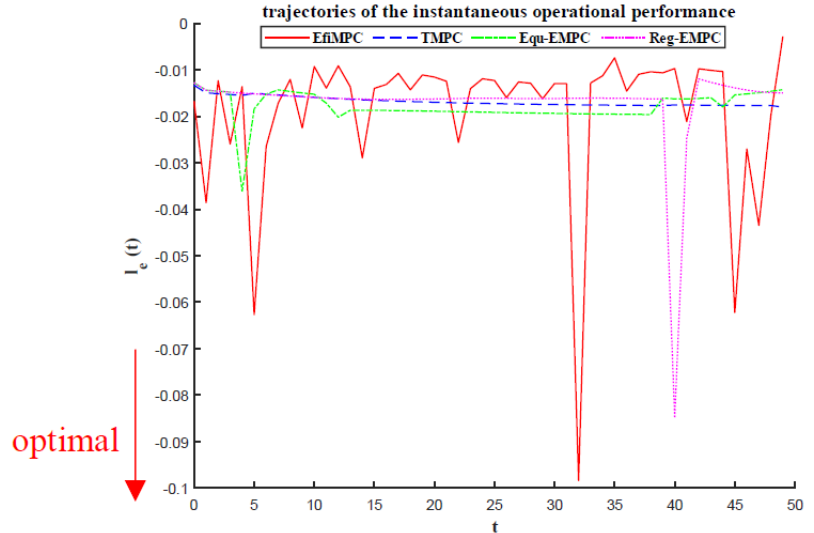
Figure 5. The instantaneous operation performance of the comparative control strategies.